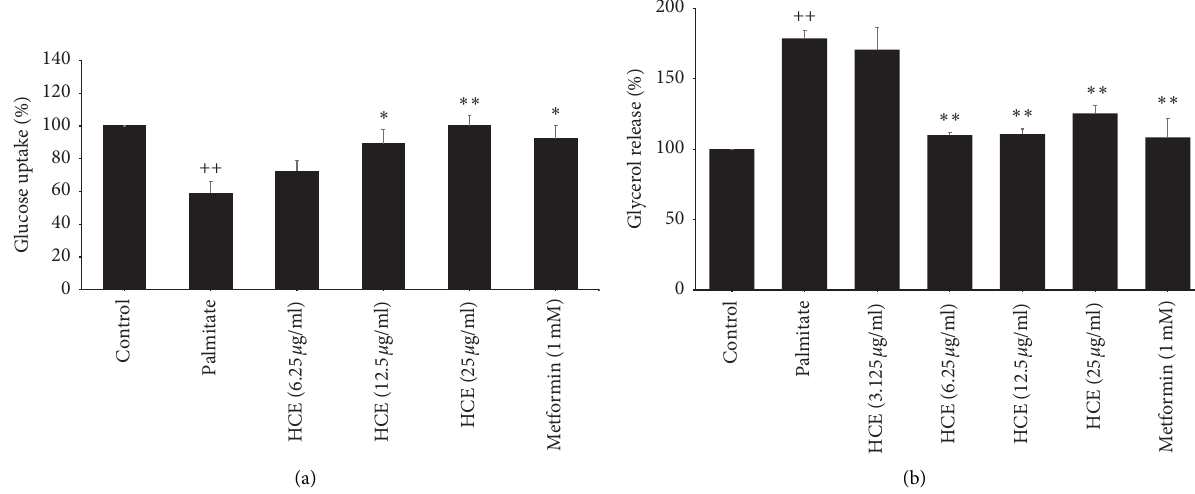
Figure 8: Effect of HCE on insulin resistance in 3T3-L1 adipocytes. (a) Glucose uptake and (b) lipolysis in palmitate-treated 3T3-L1 adipocytes. ++ p < 0 . 001 versus normal control group. ∗ p < 0 . 01 and ∗∗ p < 0 . 001 versus palmitate-treated